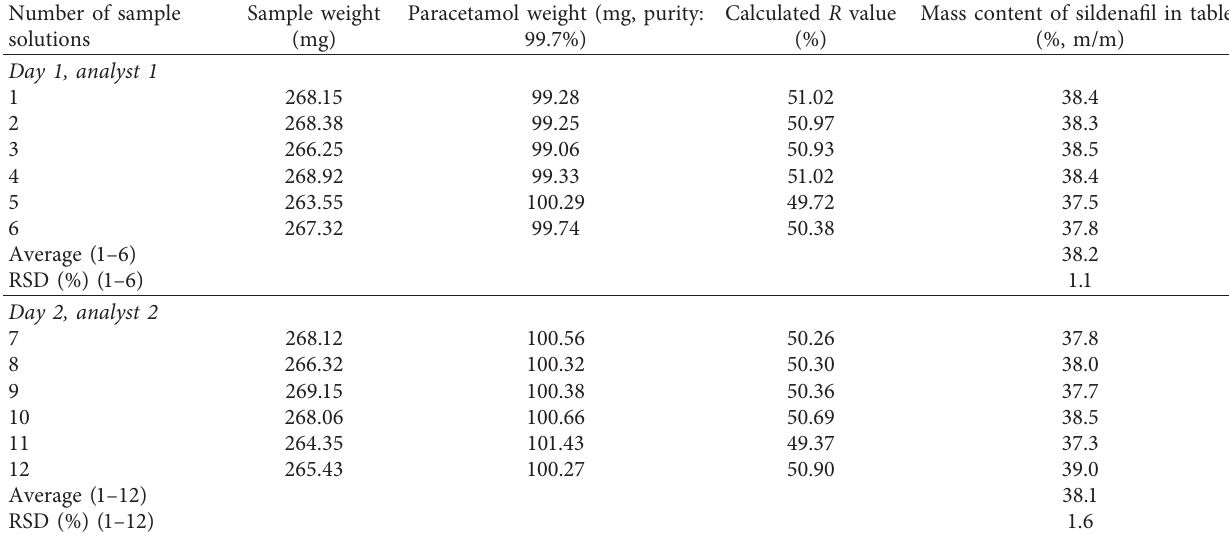
Table 3: Results of repeatability and intermediate precision.